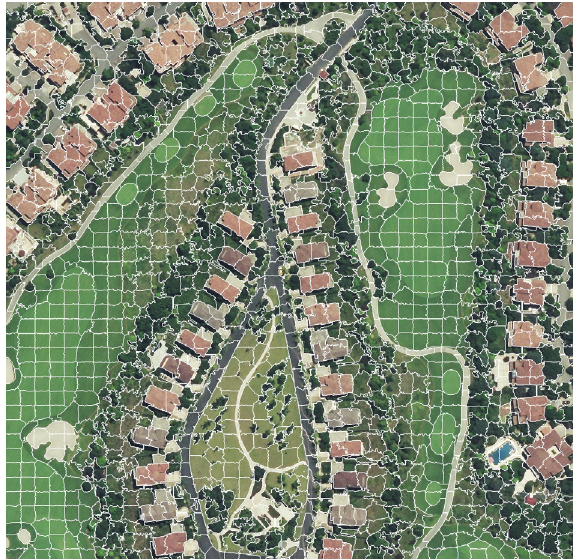
Figure 2. Orthophoto after SLIC superpixel segmentation